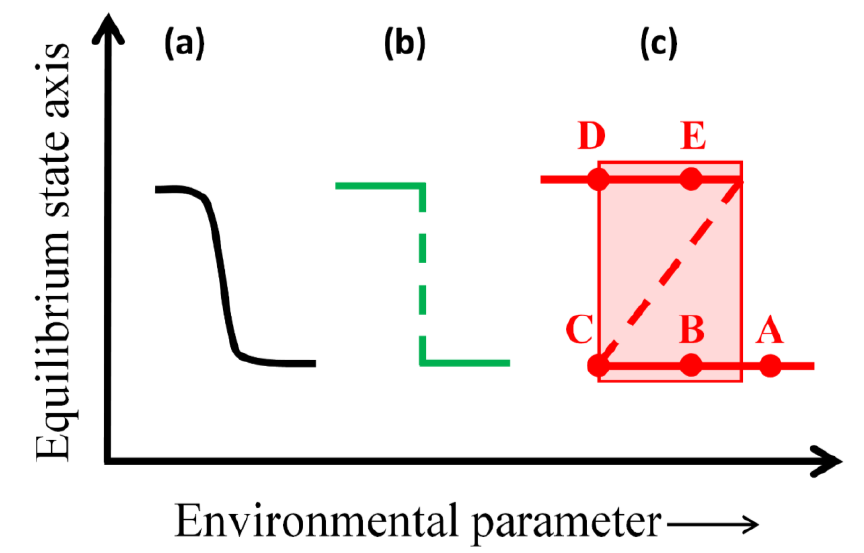
Figure 2. Schematic of different equilibrium ecosystem states (modified from [101]). ( a ) A continuous and gradual “phase shift” from “upper” to “lower” mutually exclusive states as the background environmental parameter increases; ( b ) A limiting case of sudden phase shift between two mutually exclusive states; ( c ) A sudden catastrophic shift between multiple stable states (“falling” from E to A as the environmental parameter is increased) in a hysteretic system (wherein state at E cannot be immediately recovered upon parameter reversal from state A). For a system capable of multiple stable states, the states need not be mutually exclusive; given the same value of the background environmental parameter, each state ( i.e. , D/E or C/B) may exist at different spatial locations in the